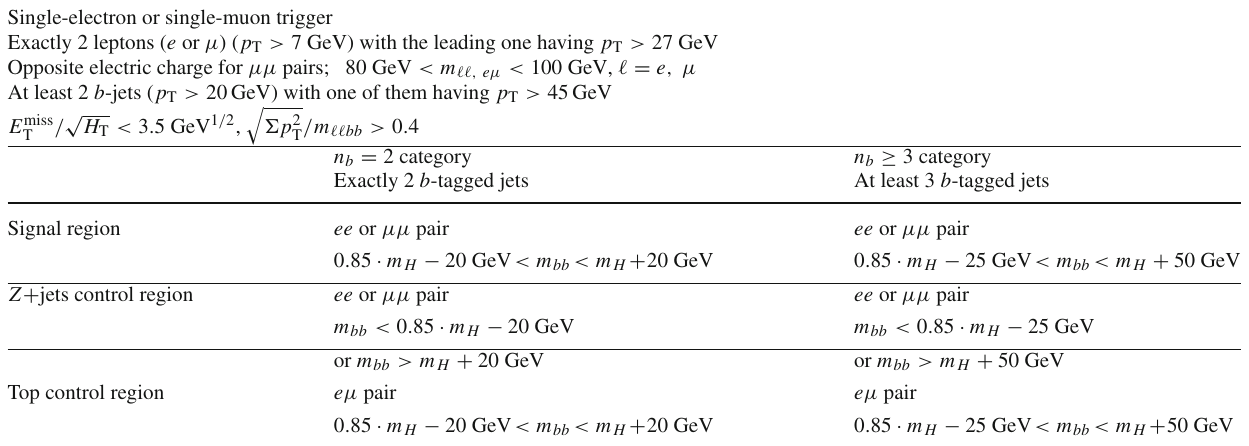
Table 1 Summary of the event selection for signal and control regions in the A → Z H → (cid:6)(cid:6) bb channel Single-electron or single-muon trigger Exactly 2 leptons ( e or μ ) ( p T > 7 GeV) with the leading one having p T > 27 GeV Opposite electric charge for μμ pairs; 80 GeV < m (cid:6)(cid:6), e μ < 100 GeV, (cid:6) = e , μ At least 2 b -jets ( p T > 20GeV) with one of them having p T > 45GeV √ / H T < 3 . 5 GeV 1 / 2 E miss T